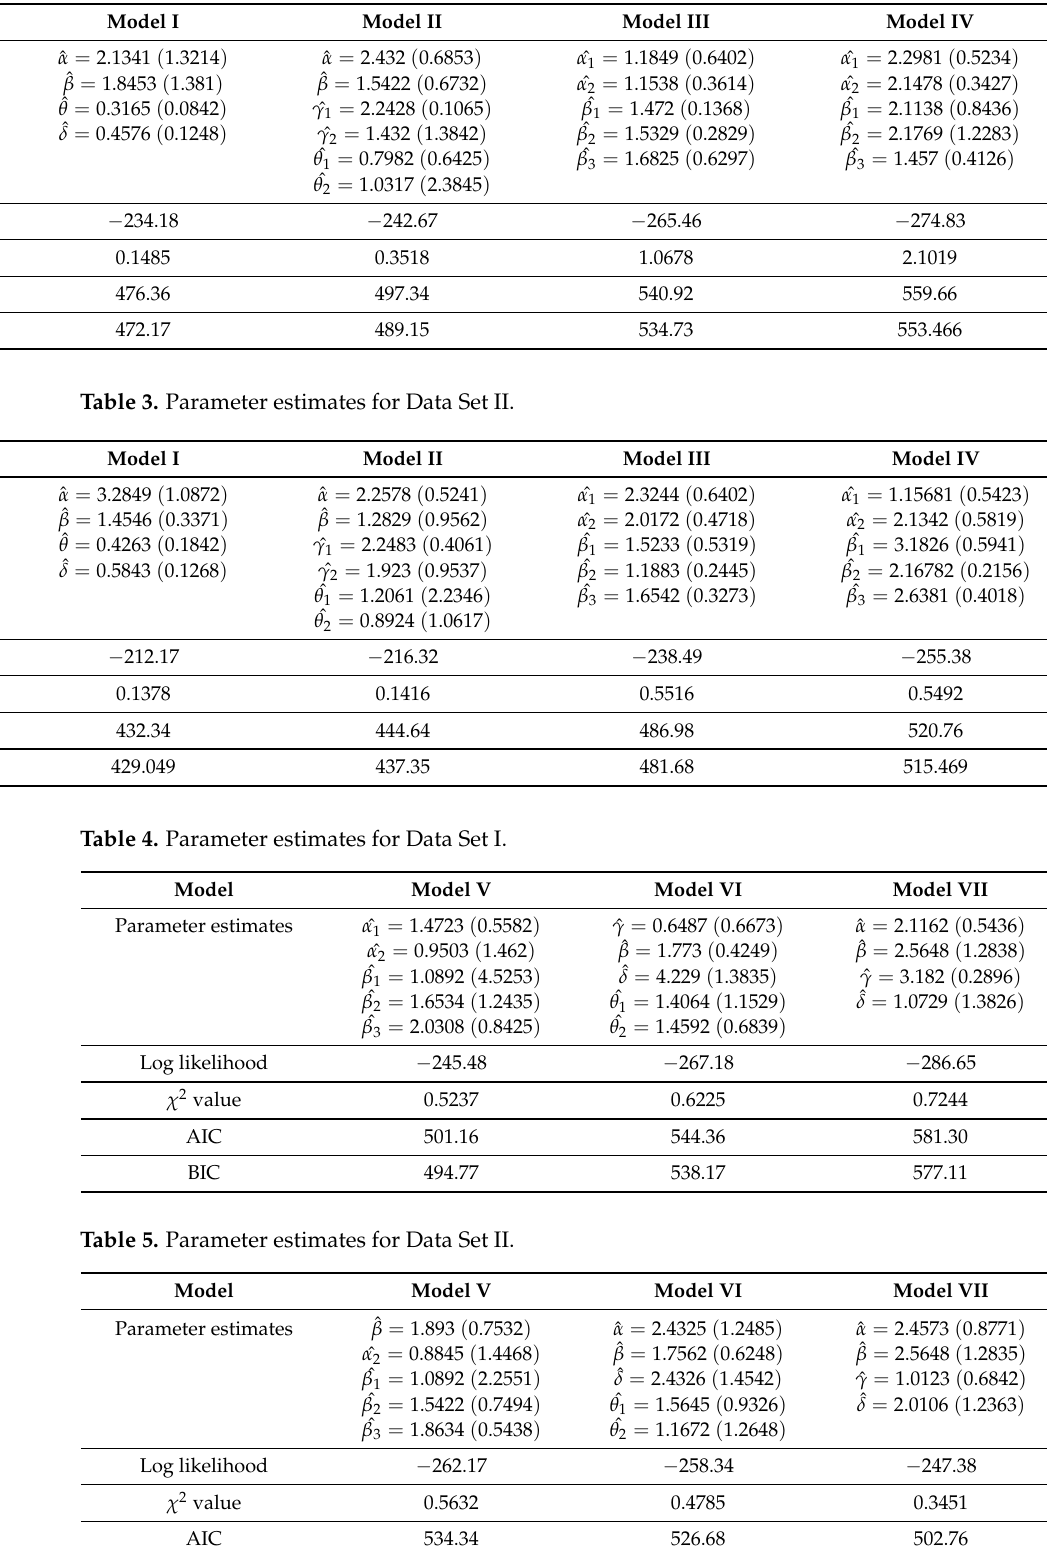
Table 2. Parameter estimates for Data Set I.